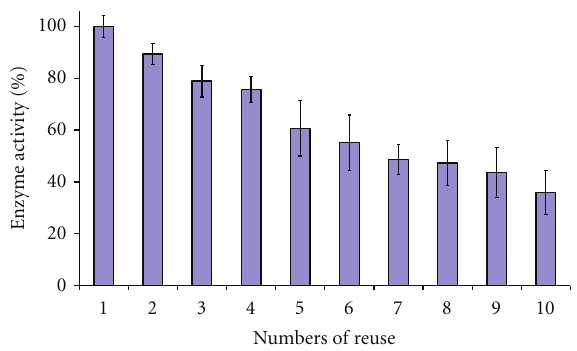
Figure 4: Evaluation of peroxidase activity maintenance after re- peated use of HRP-PANImG. Assay condition: 0.1 molL − 1 sodium phosphate bu ff er pH 6.0 and 5.0mmol L − 1 H 2 O 2 .